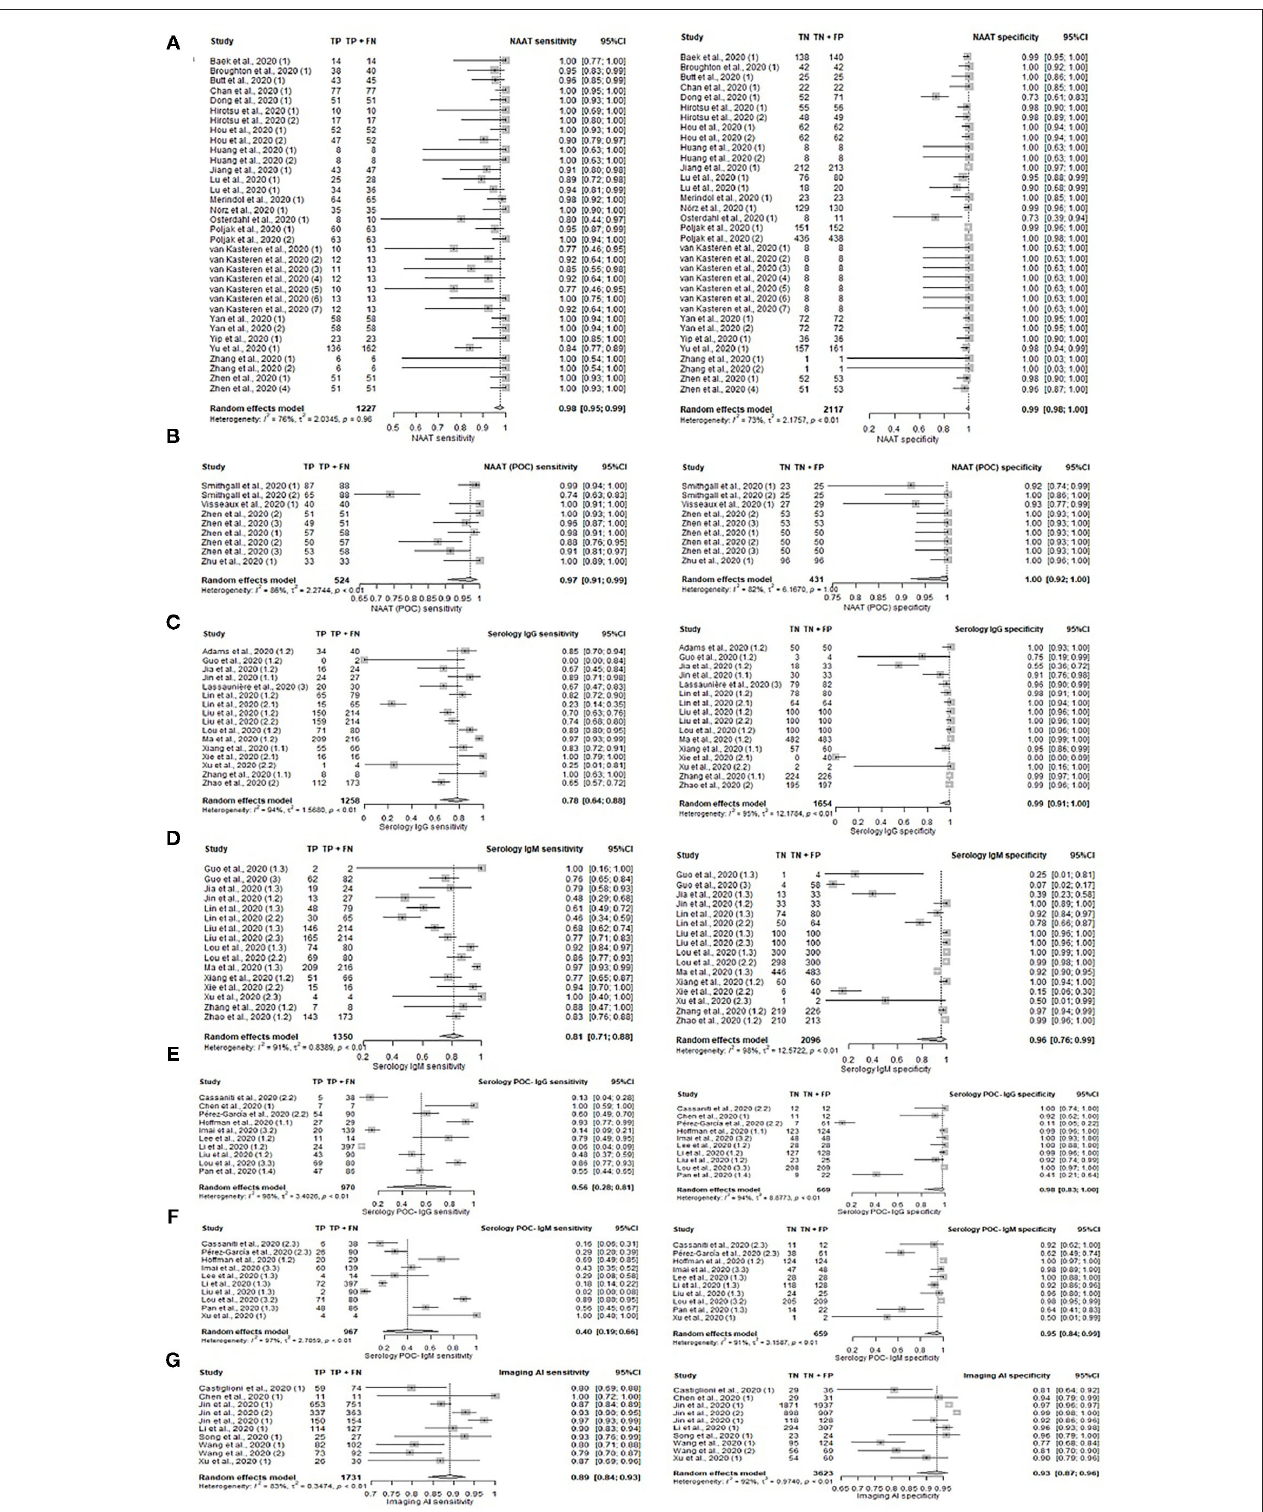
FIGURE 2 | Forest plot on diagnostic accuracy test. Sensitivity and specificity for (A) NAAT, (B) NAAT (POC), (C) serology IgG, (D) serology IgM, (E) serology IgG (POC), (F) serology IgM, and (G) Imaging (AI).